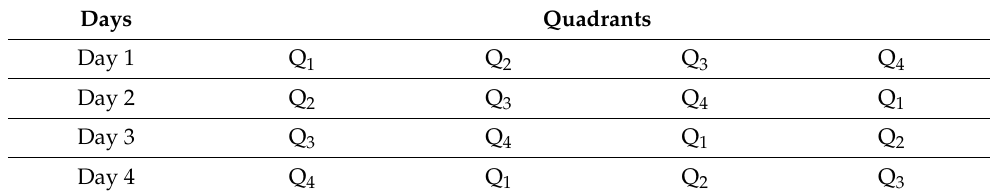
Figure 6. Image of MWM test apparatus. Abbreviation : Q, quadrant. Table 4. Behavioral assessment patterns of days vs.